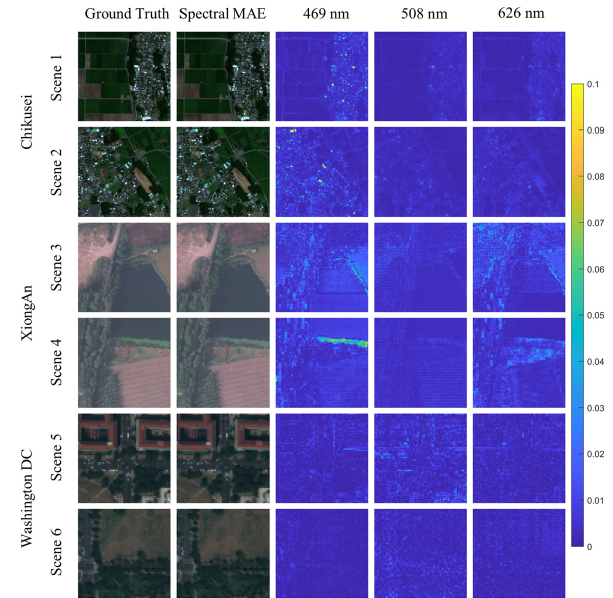
Figure 10. Visualization of the error maps between ground truth and the reconstructed results of SpectralMAE on Chikusei, XiongAn and Washington DC Mall datasets with only three channel inputs. The second column is the synthesized RGB image of the reconstructed spectral image.